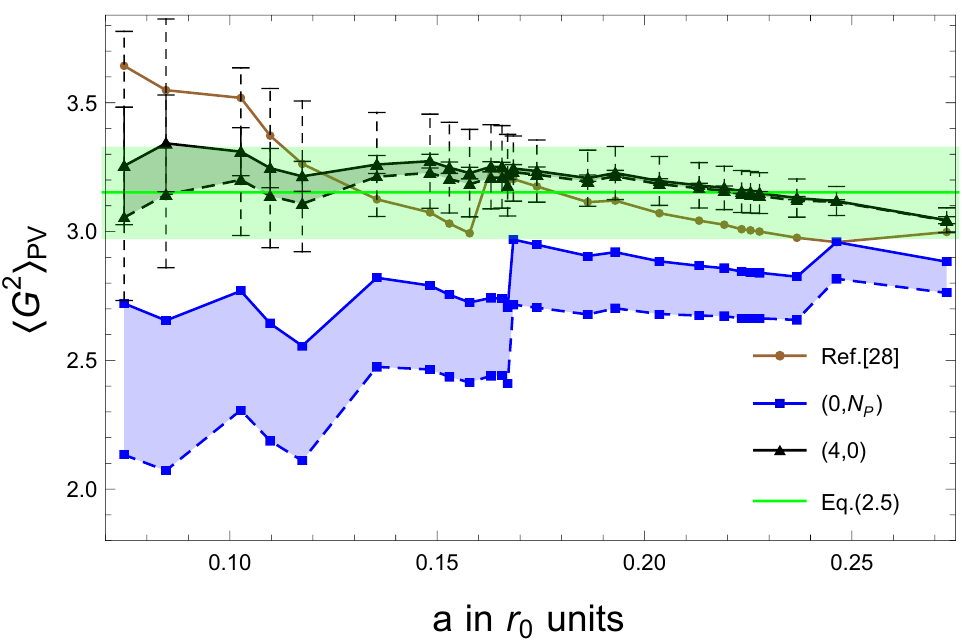
Figure 2 . Gluon condensate with superasymptotic approximation (0 ; N P ) and with hyperasymp- totic accuracy (4 ; 0). In both cases, for each corresponding (cid:12) , we show the value obtained for the gluon condensate with the values of N P using the smallest positive (upper line) and negative (lower line) value of c that yields an integer value of N P . For the hyperasymptotic approximation with c positive we also show the statistical errors of the MC determination of the plaquette (inner error) and its combination in quadrature with the statistical error of the partial sum (outer error). We also show the superasymptotic approximation obtained in [28] truncating at the minimal term determined numerically. The horizontal green band and its central value are our (cid:12)nal prediction, and the associated error, for the gluon condensate displayed in eq.